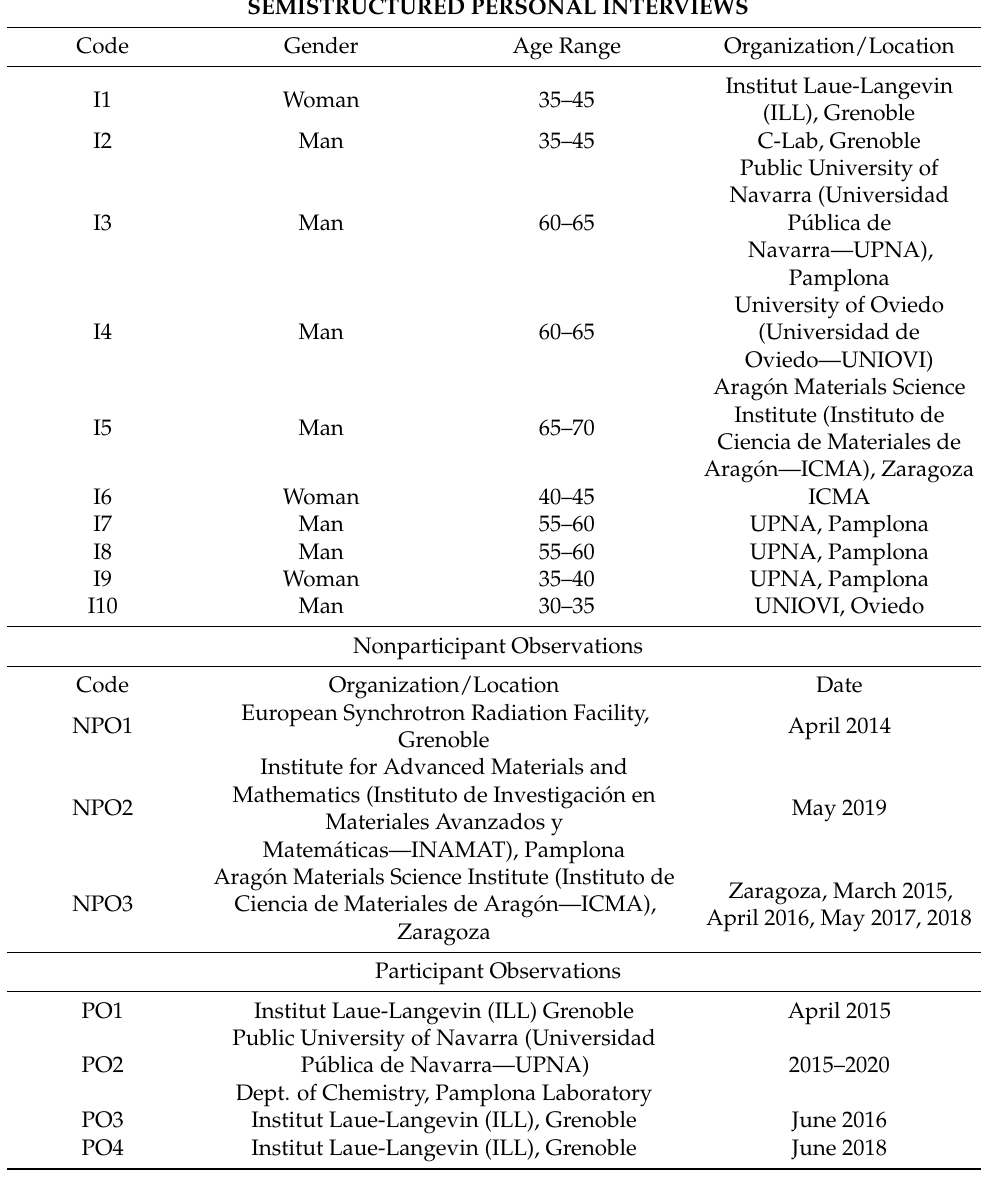
Table 1. Interviews and participant and nonparticipant observations conducted during field